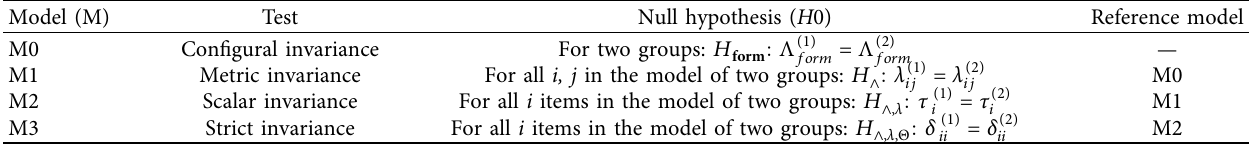
Table 1: Statistical hypotheses for the invariance analysis.